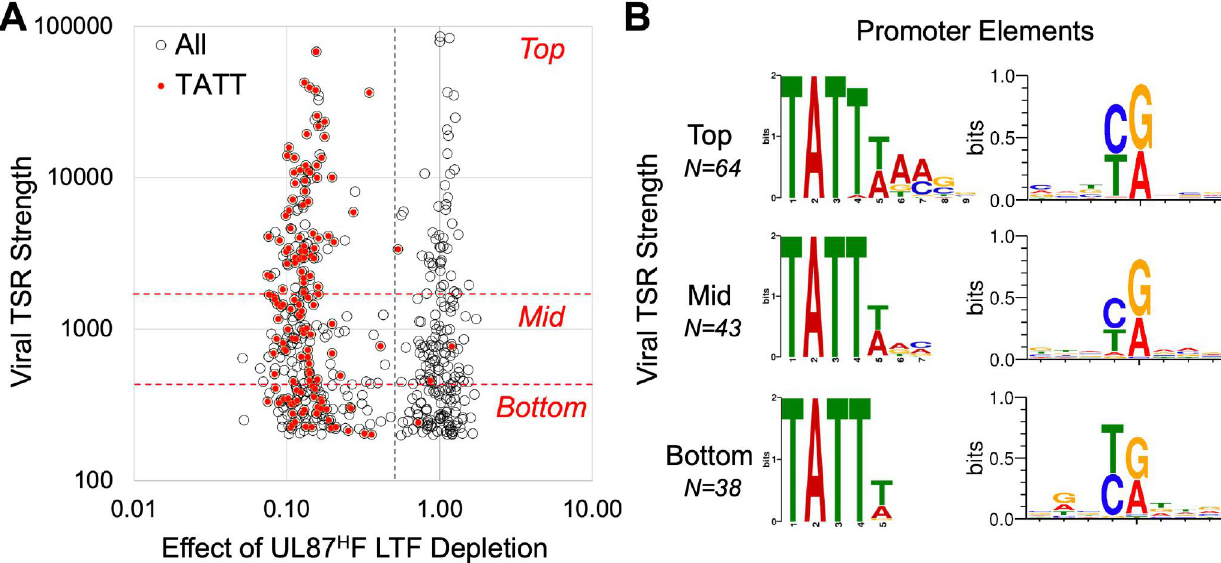
Fig 5. TATTW-containing octanucleotide sequence in relation to strength of viral promoter transcription. ( A ) Scatterplot of viral TSR strength (number of nascent RNA reads) versus effect of UL87 H F LTF depletion on TSR strength (dTag vs. CTRL treatments) for all active viral TSRs (open circles). UL87 LTF-responsive TSRs divided into top, mid, and bottom tertiles based on individual-level viral TSR strength (red hatched lines). Viral TSRs having a TATT positioned -40 to -28 upstream of the MAXTSS are marked in red. Data derived from the experiment and method of measurement described in Fig 3B . ( B ) Analysis of core promoter elements by tertile rank in TSR strength. MEME algorithm was applied to positions -50 to -20 relative to MAXTSS for UL87 LTF-responsive TSRs having an upstream TATT. WebLogo was applied to positions -4 to +4 relative to MAXTSS.